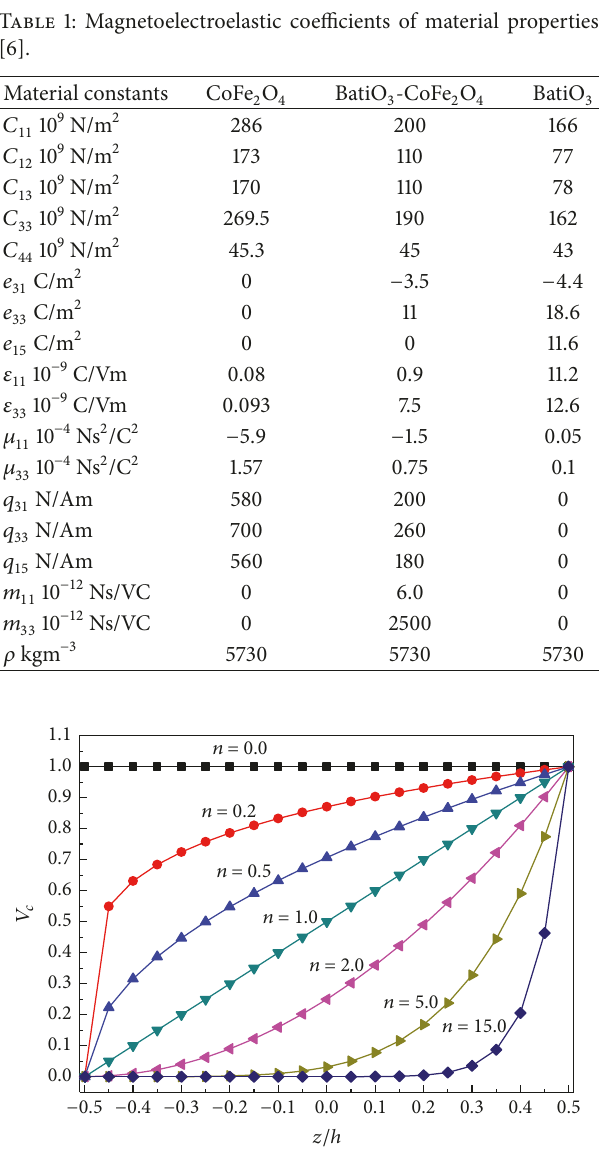
Figure 2: Variation of the volume fraction function versus the non- dimensional thickness 𝑧/ℎ with varying 𝑛